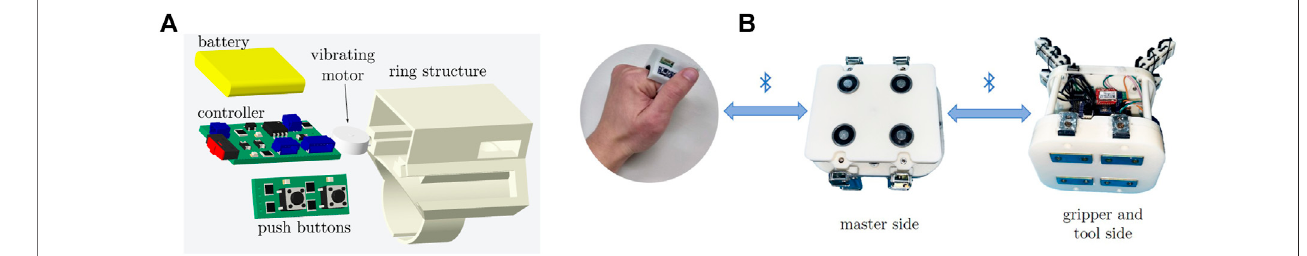
FIGURE 5 | Wearable ring interface. (A) Exploded view of its components (Salvietti et al., 2020). Push buttons can be used for controlling the activation of the electromagnets of the tool changer and the opening of the gripper. The ring also embeds a vibrating motor that starts vibrating when the magnets are active. (B) Interconnections between the interface and the detachable gripper system. The signals coming from the ring are sent via Bluetooth to the control board of the master side of the tool changer which, depending on the pressed button, either switches on/off the magnets, or sends the opening/closing signal to the gripper via Bluetooth.